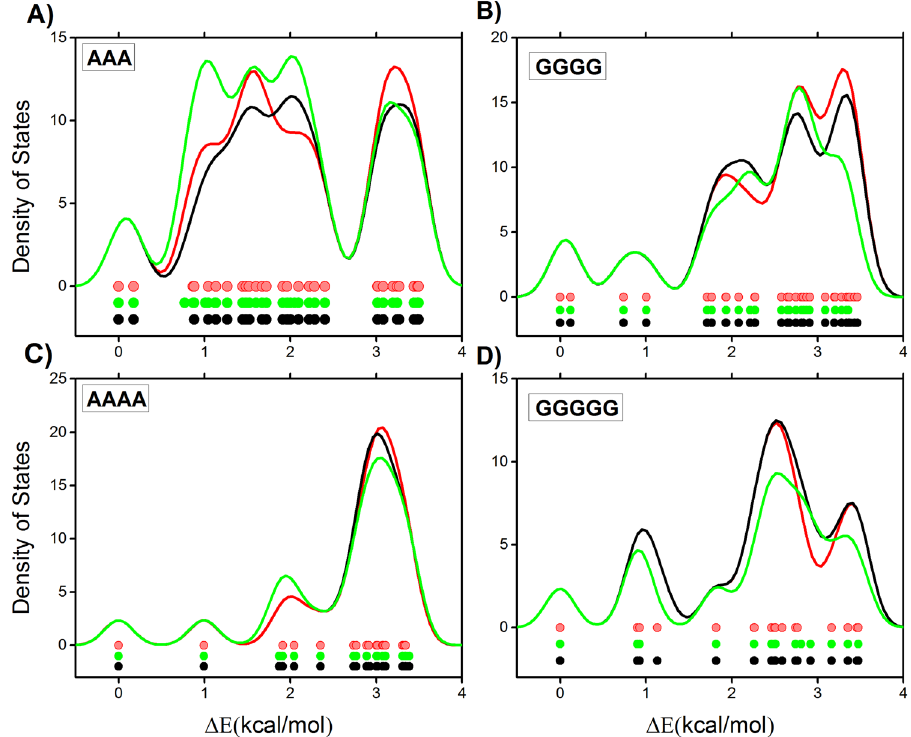
Figure 3. Results of the new search method (in red), the conventional systematic search method (in black) and the path matrix method (in green) on the obtained low-energy conformations of: ( A ) AAA, ( B ) GGGG, ( C ) AAAA, ( D ) GGGGG.